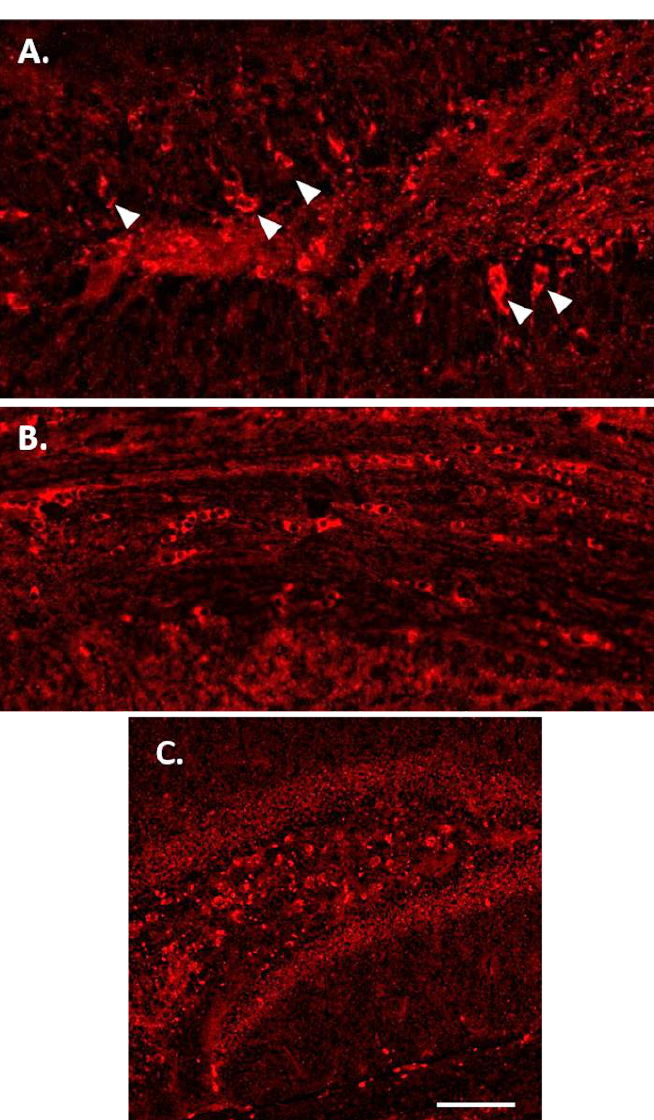
Figure 5. p-Tau immunostaining 4 months after injection of DS-AD NDEVs. There was a wide distribution of p-Tau S396-positive cells within the GCL of the dentate gyrus ( A ) and the corpus callosum ( B ). ( C ) Representative p-Tau T231 immunostaining in the hippocampus 1 month following DS-AD NDEV injection. Note the difference in distribution, with large neurons in the hilar region staining in a uniform pattern without strong “flame-like” tangle staining in the apical dendrite. Scale bar in C represents 100 microns.